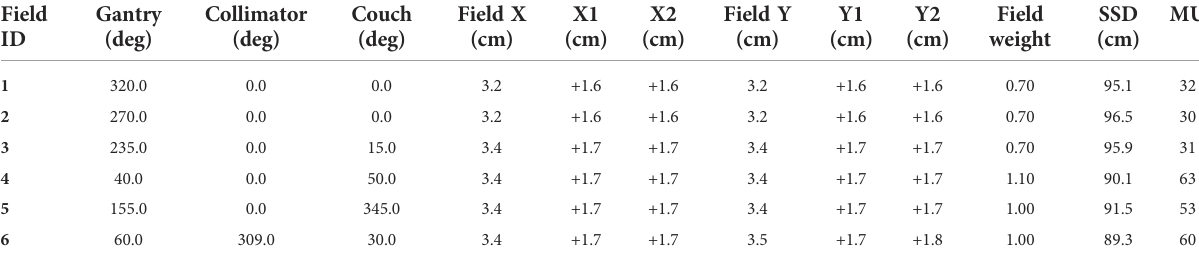
TABLE 1 3DCRT planning dose parameters.